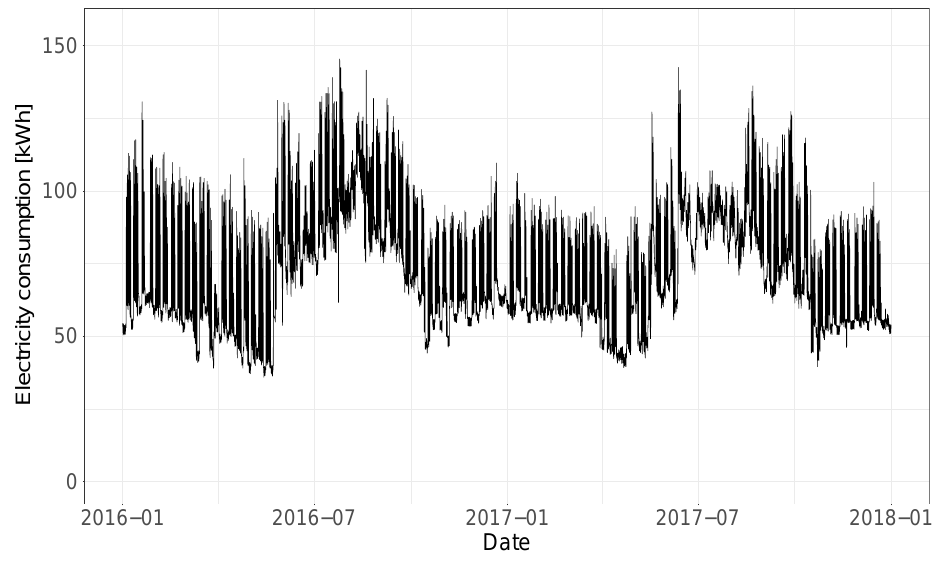
Figure 15. Electricity consumption time-series for the building Rat_education_Royal